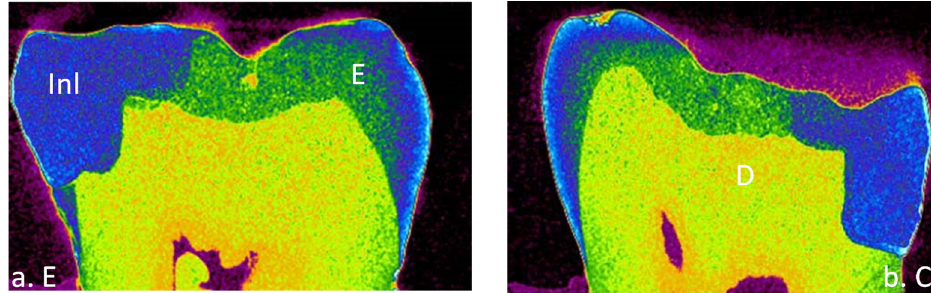
Figure 2. Micro-CT images of internal and marginal gap at the gingival floor of a Class II Lava Ultimate inlay luted with RelyX Ultimate resin cement on ( a ) enamel and ( b ) cementum/dentin. Inl, inlay; E, enamel; D, dentin.